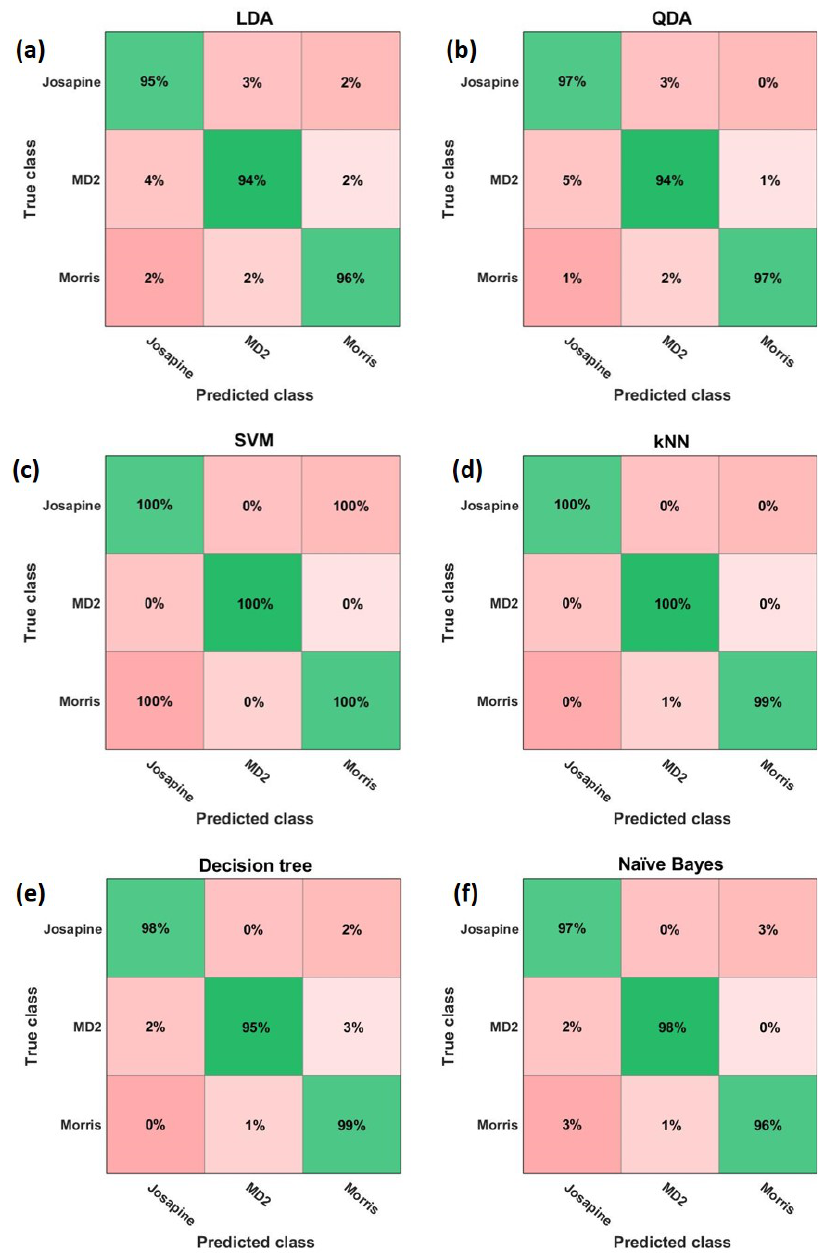
Figure 6. Confusion matrices with average classification accuracies of different pineapple cultivars using ( a ) LDA, ( b ) QDA, ( c ) SVM, ( d ) kNN, ( e ) decision tree, and ( f ) naïve Bayes. Green in the confusion matrix describes the correct classification rate, and pink describes the misclassification rate.